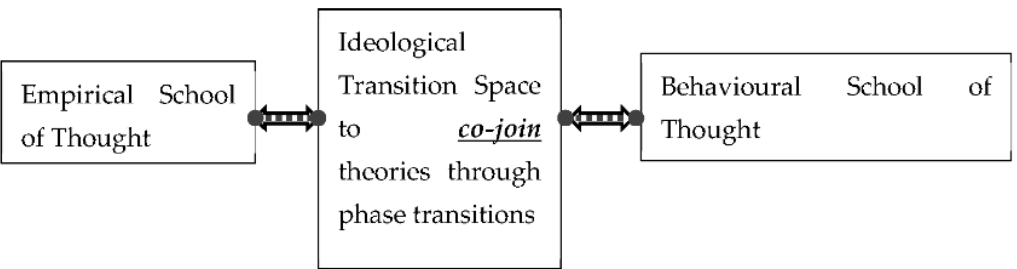
Figure 2. Theoretical conceptualisation for removing parallel theoretical upbringings through causal linkages as a co-joining mechanism.